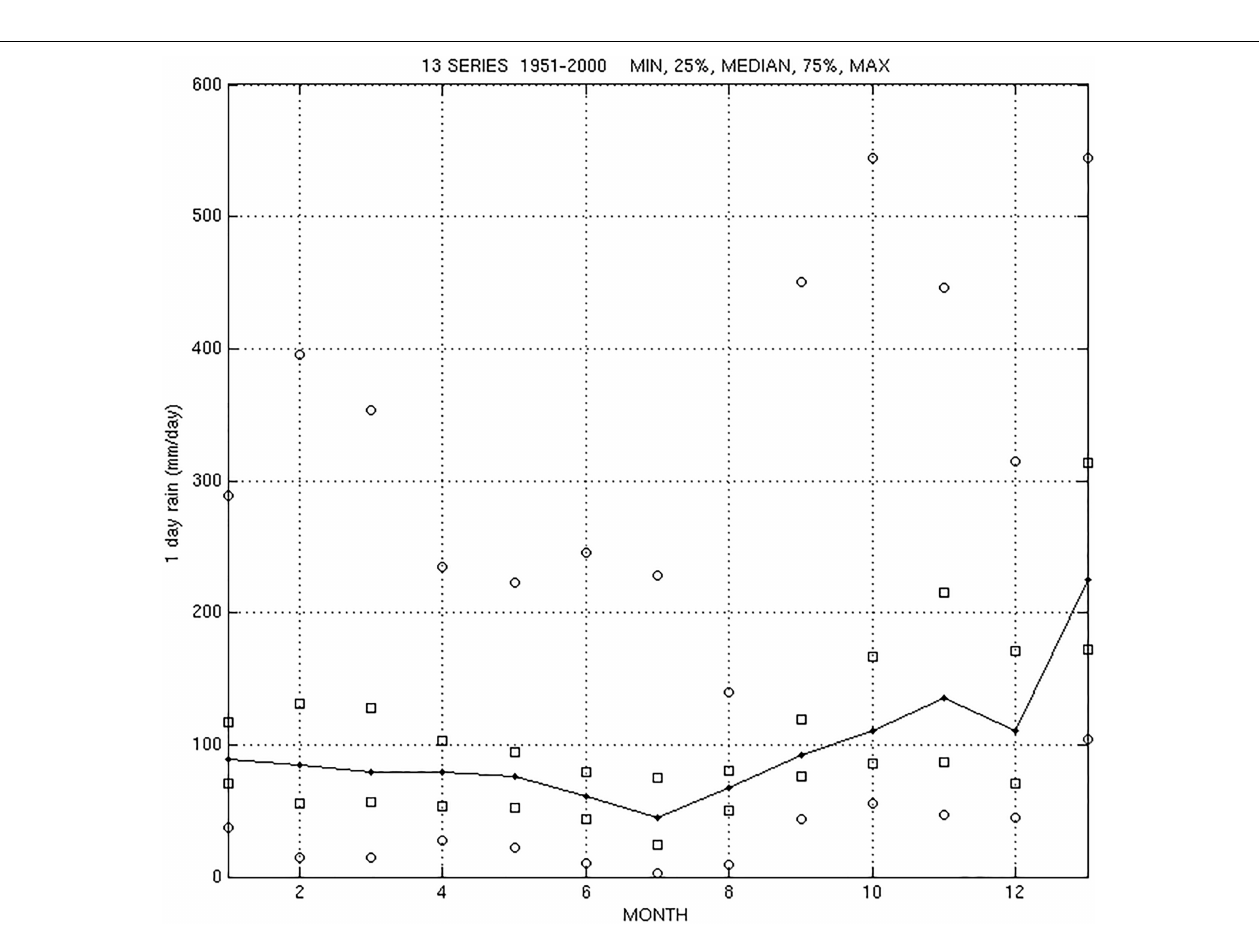
FIGURE 2 | Minimum, 25%, median, 75%, maximum of 12 monthly and yearly